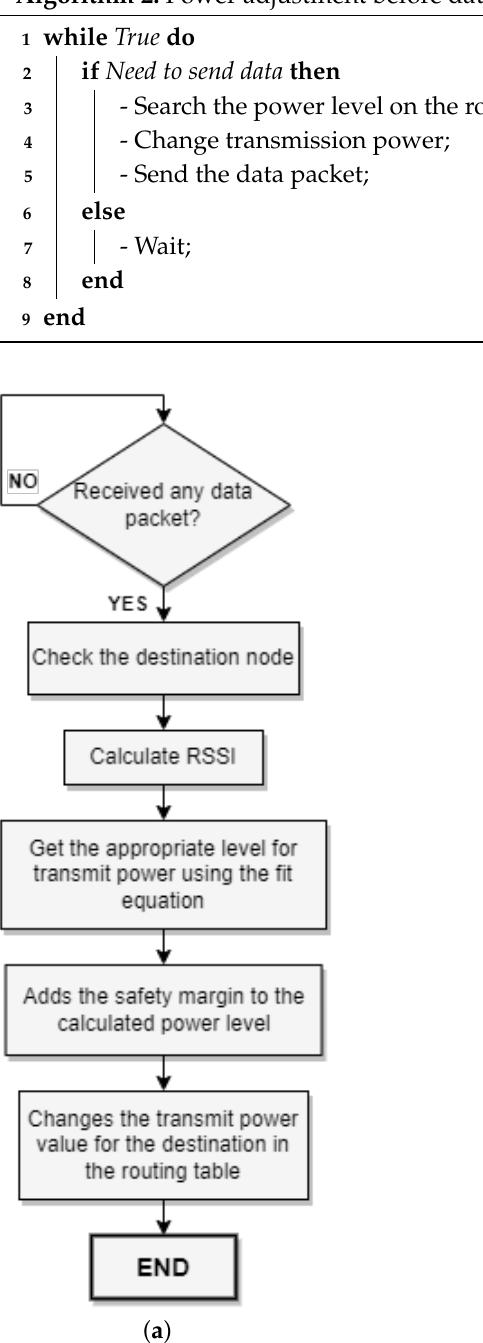
Algorithm 2: Power adjustment before data transmission.